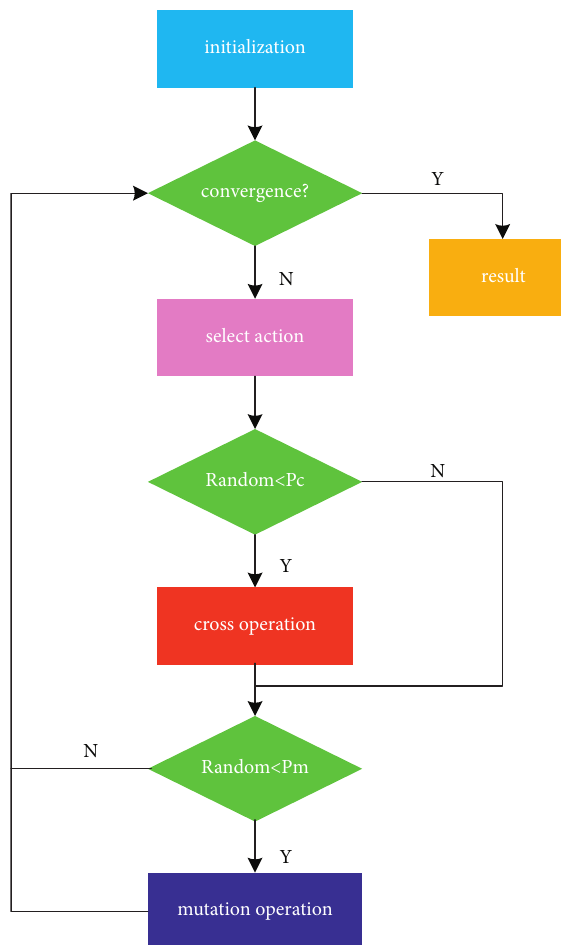
Figure 3: Block diagram of the genetic algorithm optimization